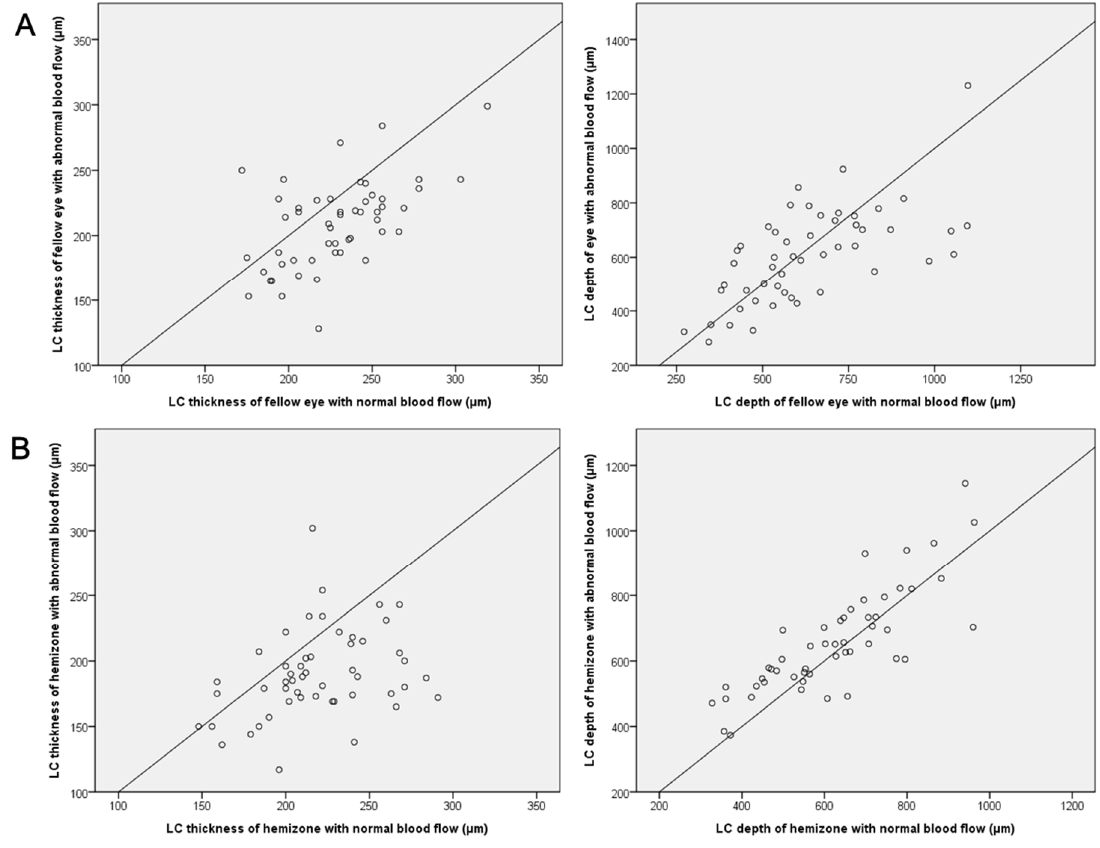
Figure 2. Scatter plots showing comparisons of the thickness and depth of lamina cribrosa ( A ) between eyes with deep vessel density (VD) defects and the contralateral eyes with intact VD, and ( B ) between hemizones with deep VD defects and the other hemizones with intact VD in OCT angiography. Table 4. Factors associated with deep VD defects from